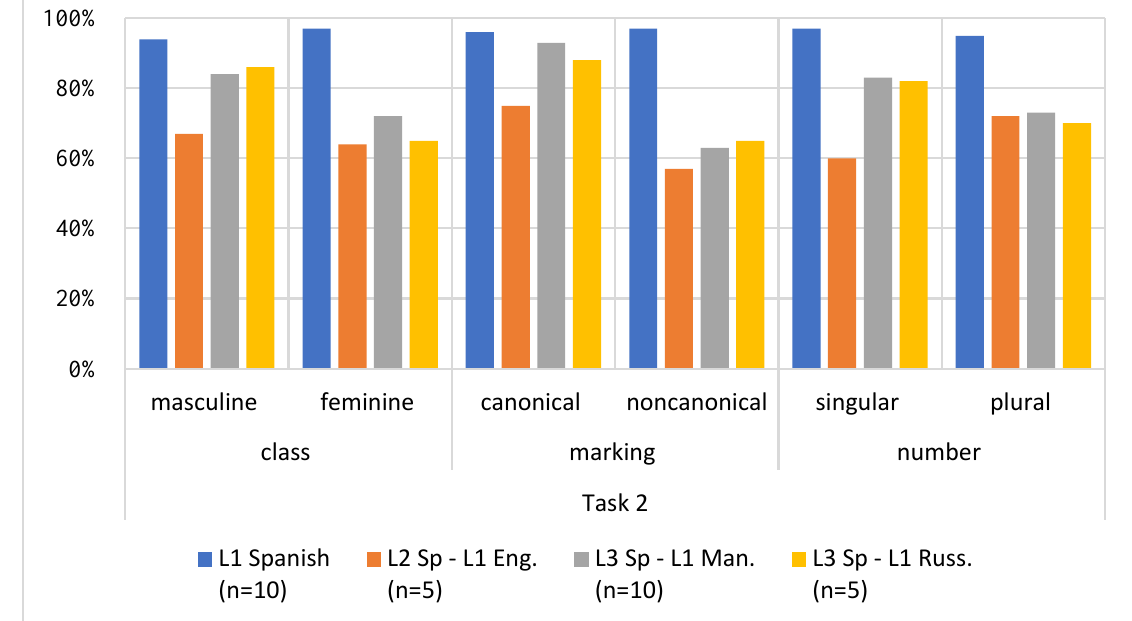
Figure 1. Accuracy Scores among three language groups in Task 1.